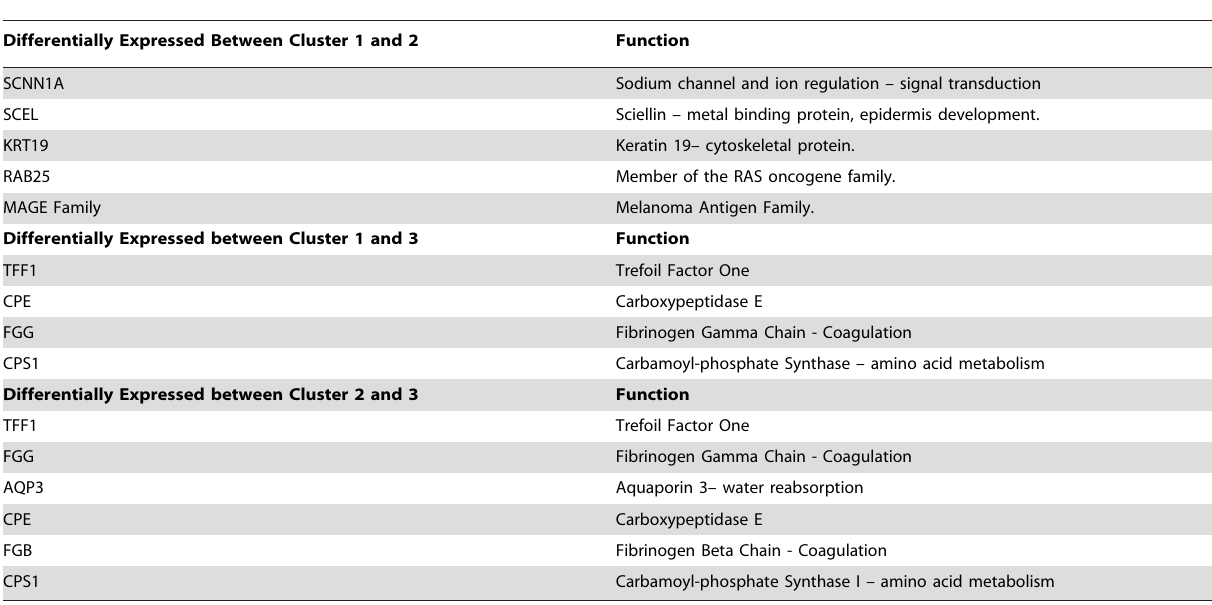
Table 4. Differentially Expressed Genes Between the Different Clusters.